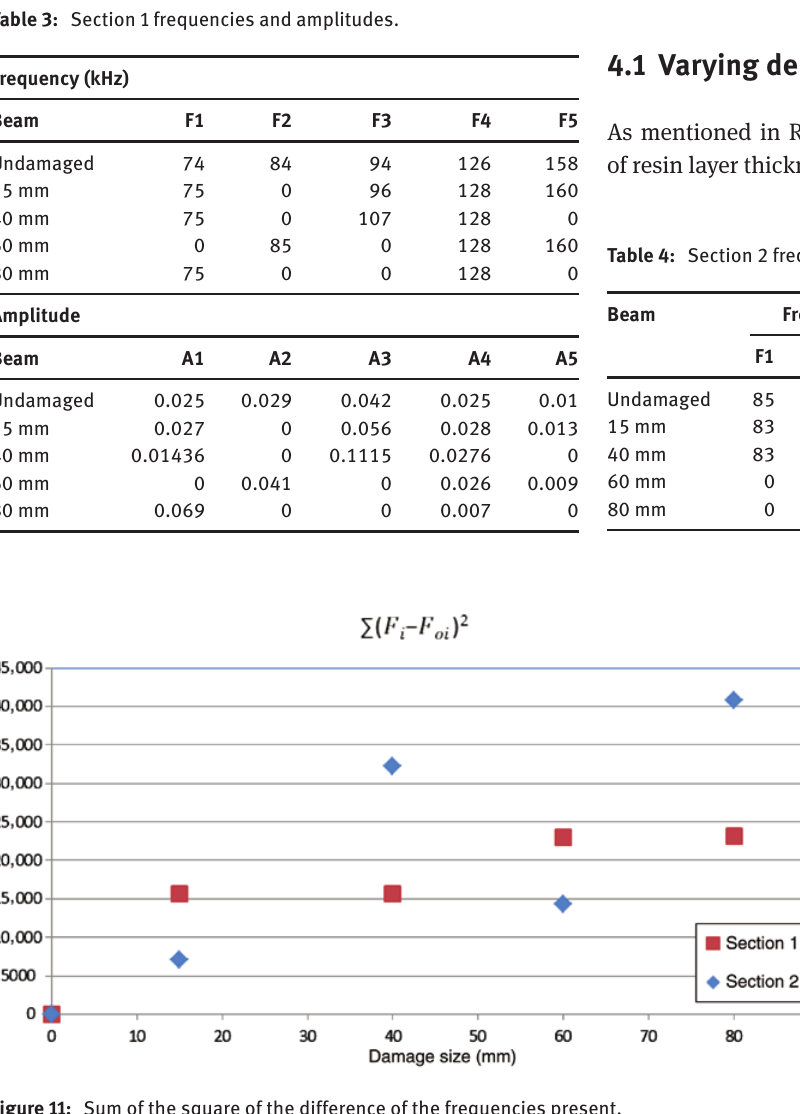
Figure 11: Sum of the square of the difference of the frequencies